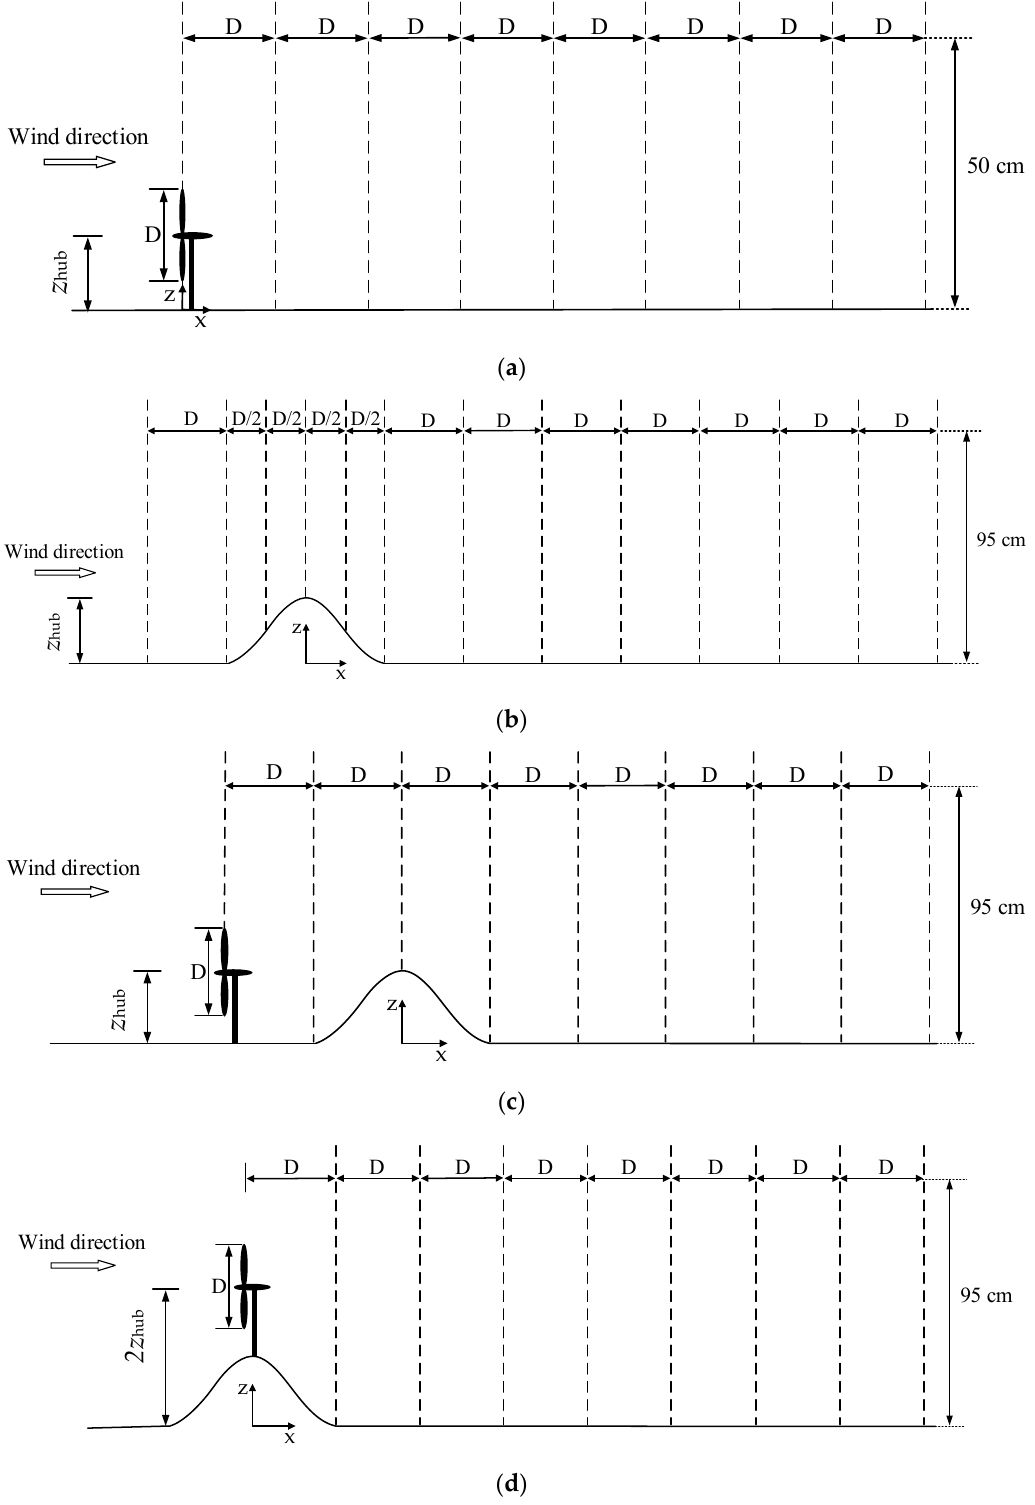
Figure 5. Schematic diagram of four experimental layouts. ( a ) Flat terrain with a single wind turbine (case 1); ( b ) only the hilly terrain (case 2); ( c ) hilly terrain with a wind turbine in front (case 3); ( d ) hilly terrain with a wind turbine on the hilltop (case 4).